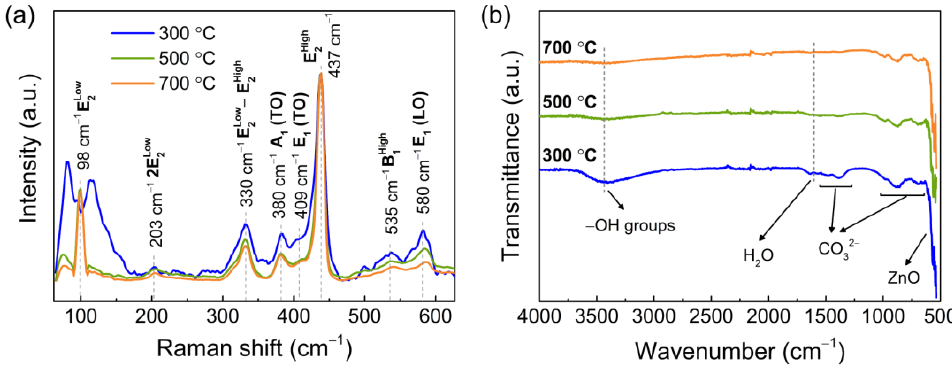
Figure 2. ( a ) Raman spectra and ( b ) FTIR spectra of porous ZnO nanostructures calcinated at 300, 500, and 700 °C.